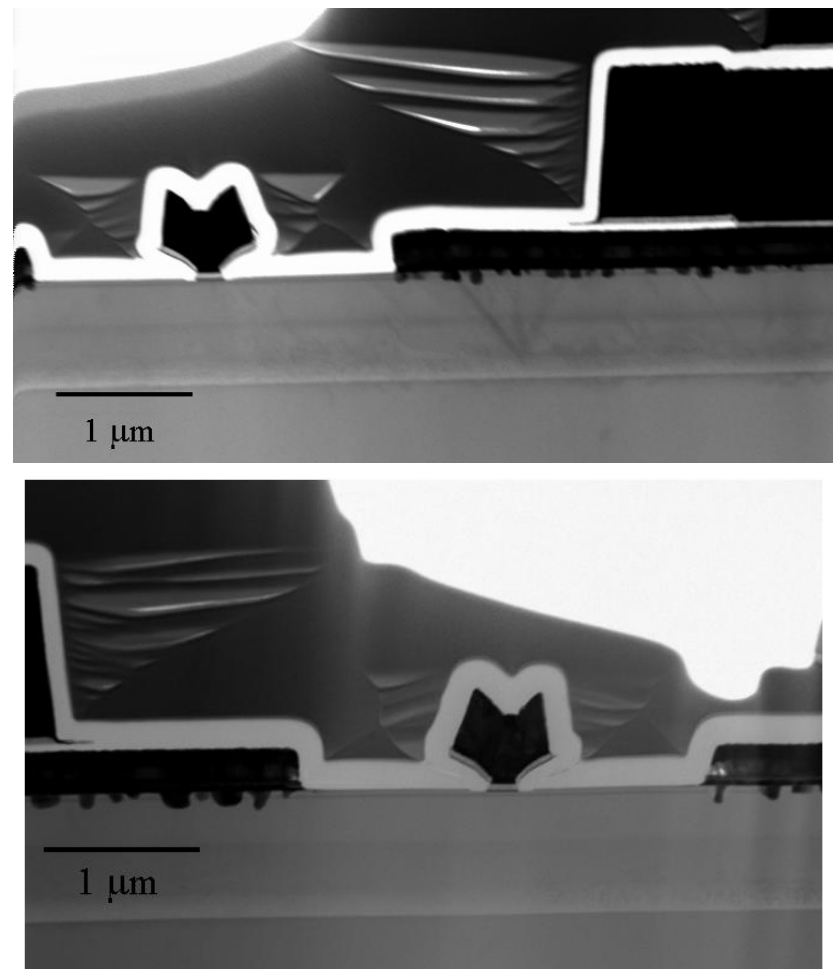
Figure 11. Low magnification cross-section view TEM image of InAlAs/InGaAs MHEMT after storeage at 250 °C for 48 h ( a ) Low magnification cross-section view TEM image of InAlAs/InGaAs MHEMT after DC stress for 36 h ( b ). Reprinted with permission from [62]. Copyright 2010 American Vacuum